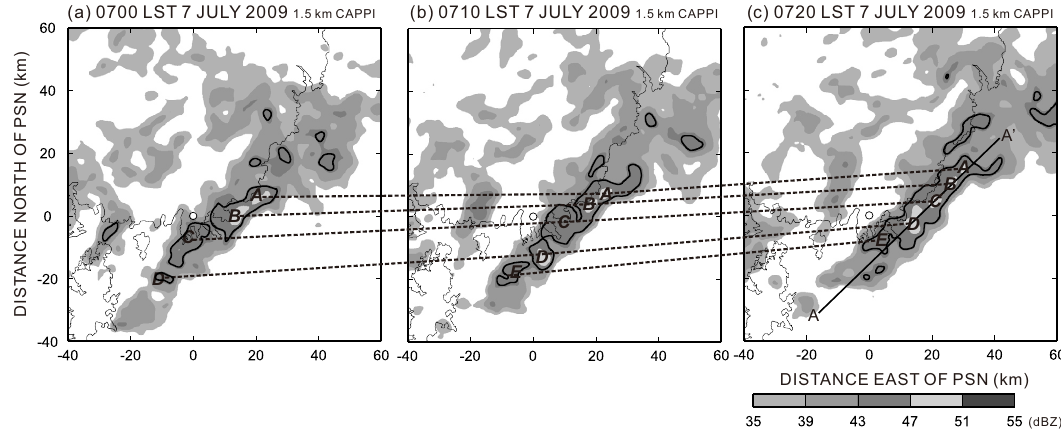
Figure 9. Horizontal section of radar reflectivity (dBZ, shading) at a height of 2km observed by PSN the radar at 10min intervals from (a) 07:00LST to (c) 07:20LST 7 July 2009. The contour denotes 45dBZ. In (c) the line A–A (cid:48) shows the location of the vertical cross section used in Fig. 10.